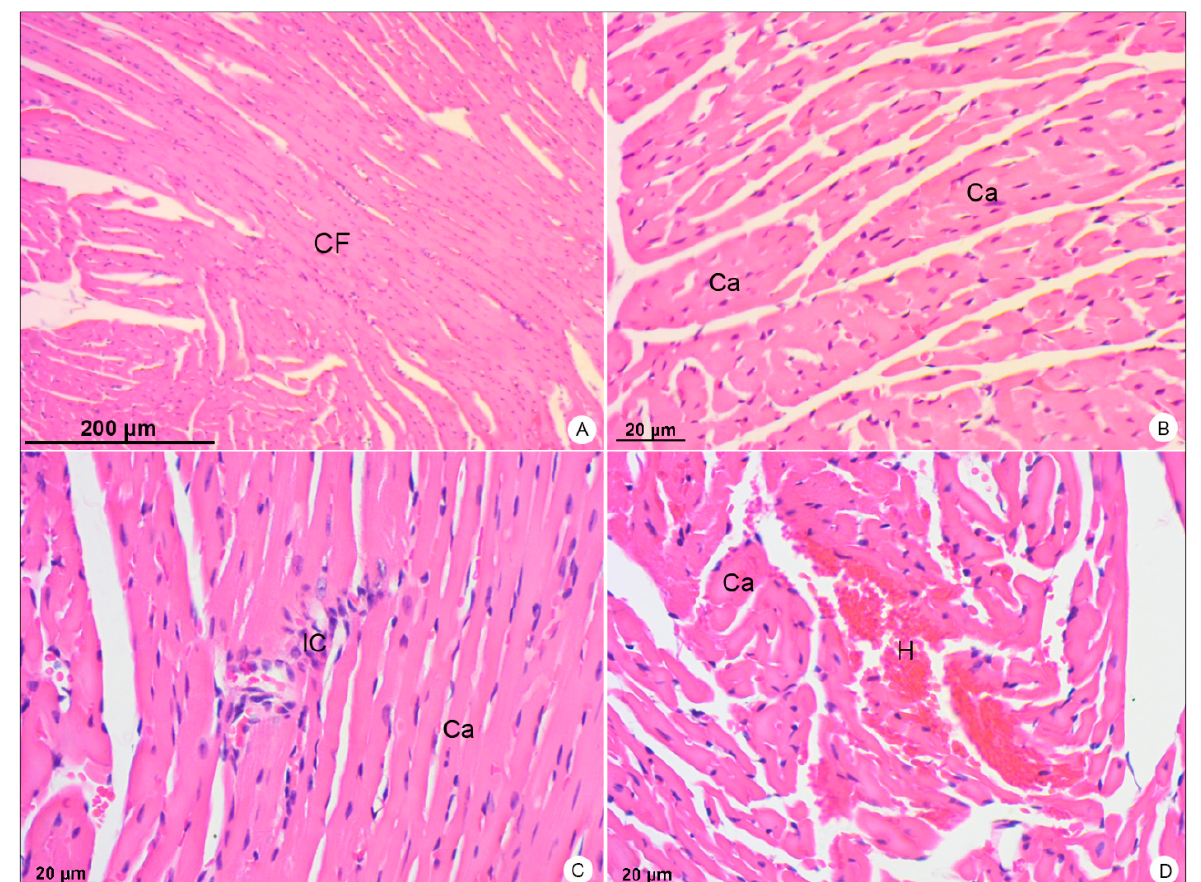
Figure 6. Heart samples of BALB/c mice stained with hematoxylin and eosin and observed in bright field microscope. ( A , B ) Negative control samples. Cardiac Fibers (CF); cardiomyocytes (Ca). ( C , D ) DENV-4-infected samples. Inflammatory infiltrate (IC); area of hemorrhage (H). Magnification: ( A ) = 50×; ( B ) = 200×, ( C ) = 200×; ( D ) = 200×.